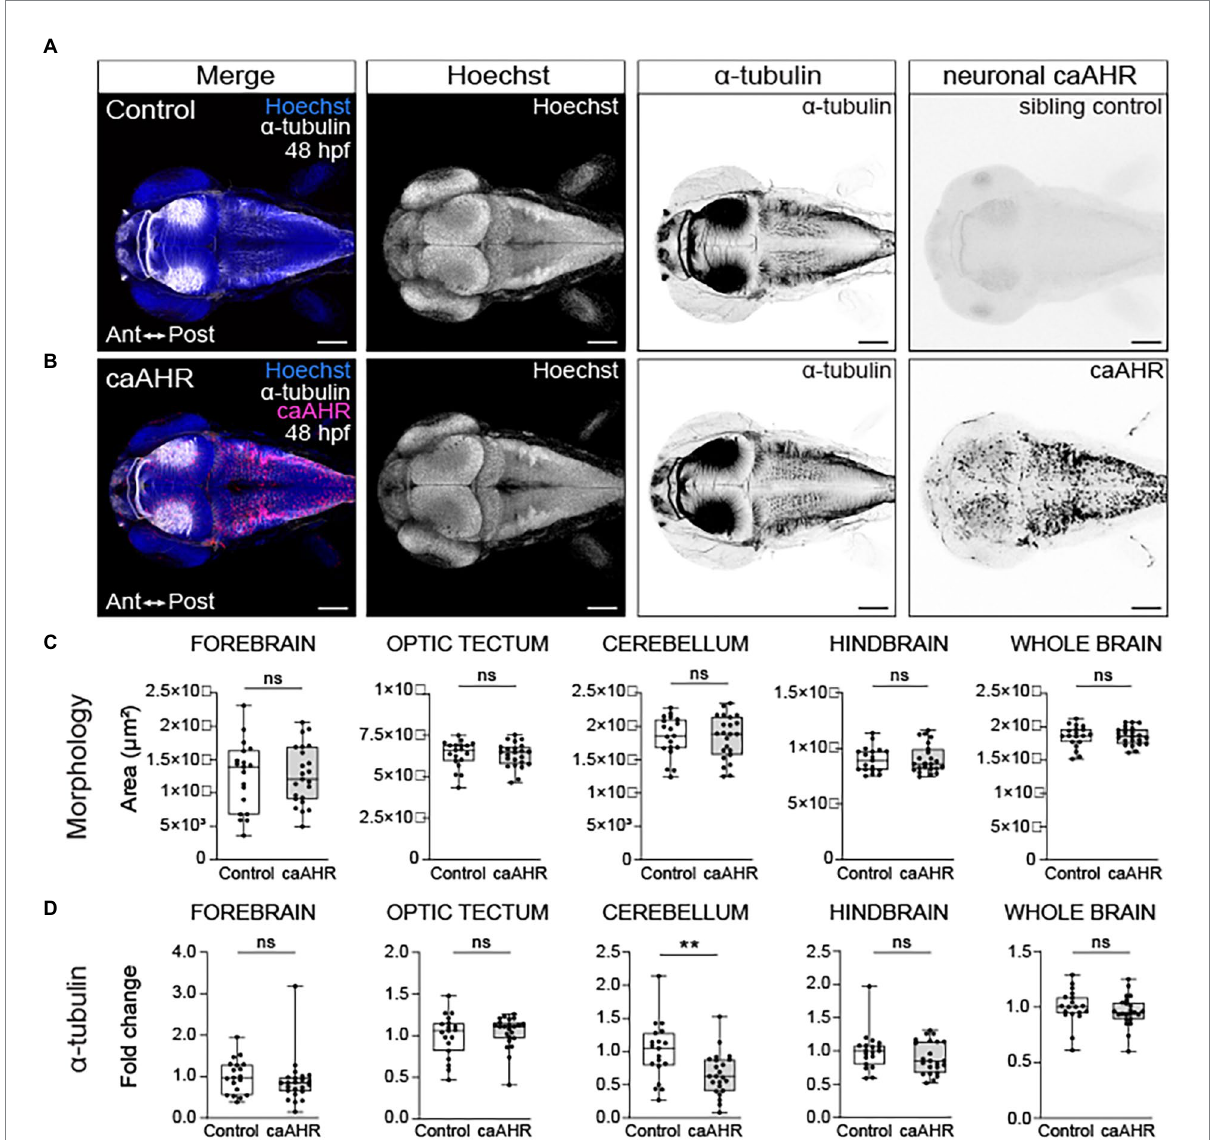
FIGURE 7 Neuron-specific activation of AHR disrupts the development of the cerebellum without affecting brain regions disrupted by global AHR activation. Confocal images at 48- hpf of control embryos (A) and embryos with neuron-specific expression of a constitutively active AHR [ Tg(elav3l:Gal4;UAS:caAHR:2A-tRFP) ] (B) . Embryos were stained with Hoechst (blue in the first panel and white in second panel of both A,B ) to visualize the brain parenchyma and immunolabeled with an anti-acetylated alpha tubulin antibody ( α -tubulin) to mark axon tracts (white in the first panel and inverted black in the third panel of both A,B ). There were no differences in the morphology of the forebrain, optic tectum, cerebellum, hindbrain, and whole brain at 48 hpf when comparing control (C) embryos to embryos with neuron-specific expression of a constitutively active AHR. (D) Fold change in acetylated α -tubulin expression in the forebrain, optic tectum, cerebellum, hindbrain, and whole brain in control and Tg(elav3l:Gal4;UAS:caAHR:2A-tRFP embryos relative to mean area coverage of α -tubulin in wild-type embryos. Statistical significance determined by Welch’s t -test, * p < 0.05, ** p < 0.01, *** p < 0.001. n = 19–23 fish/group across 3 replicates. Anterior (Ant) is left in all confocal micrographs. Scale bar = 100 μ m. Magnification =